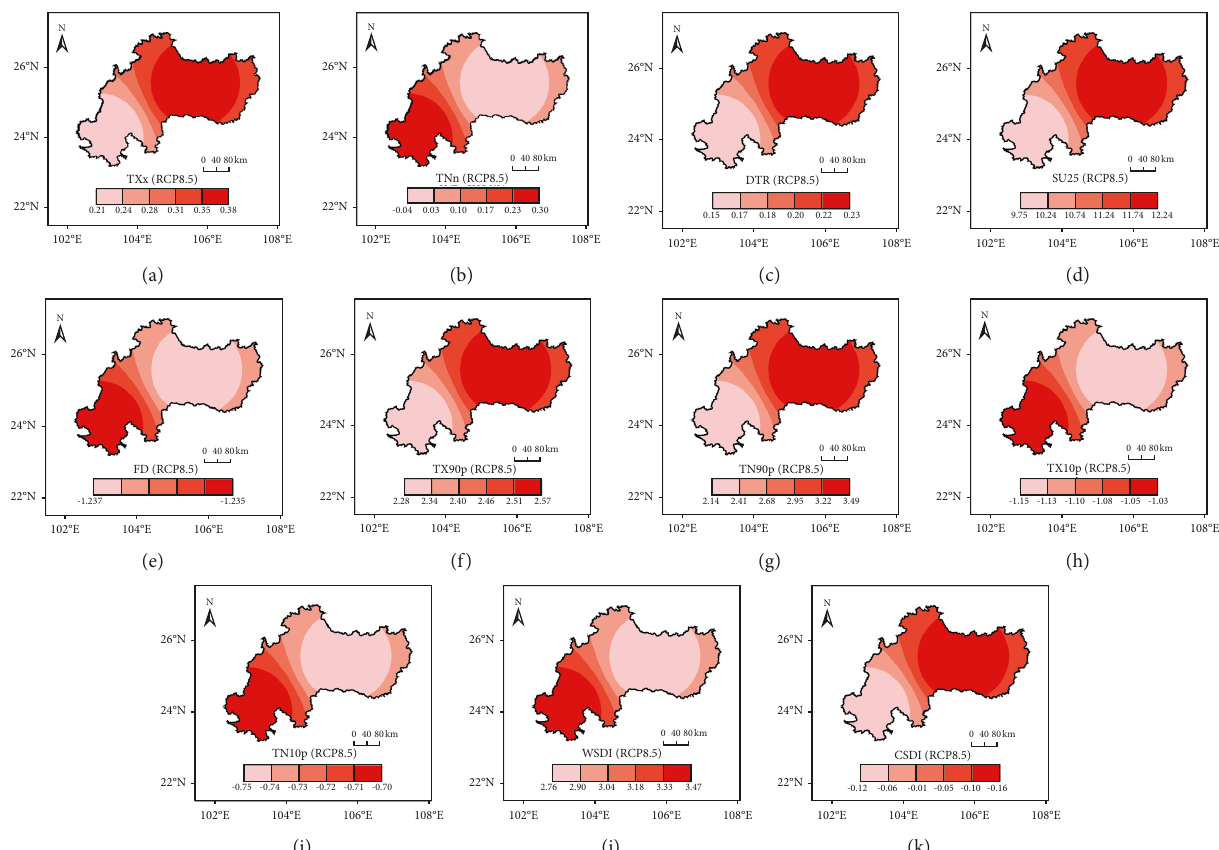
Figure 8: Spatial distribution of interdecadal variability of temperature extremes for 2021–2050 under the